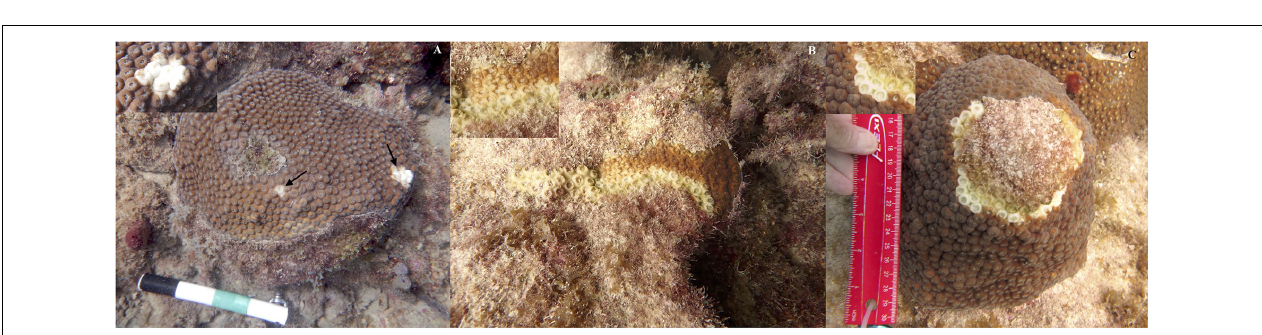
FIGURE 6 | Examples of the three types of lesion morphologies associated with SCTLD. (A) bleached polyps, (B) tissue loss bordered by bleached polyps, and (C) tissue loss without distinct bleached